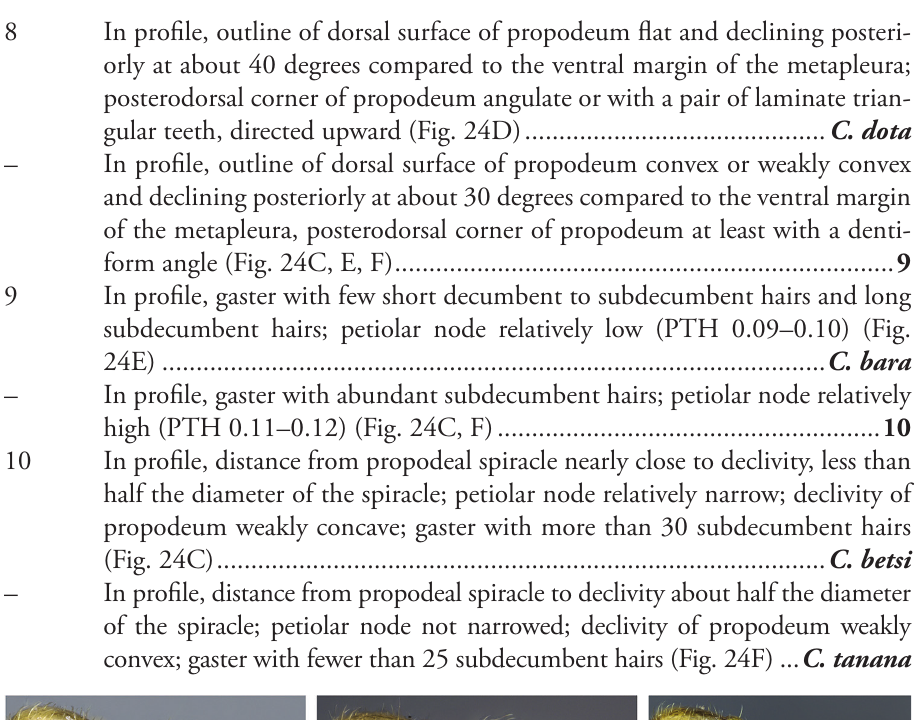
(Fig. 24C) ......................................................................................... C. betsi